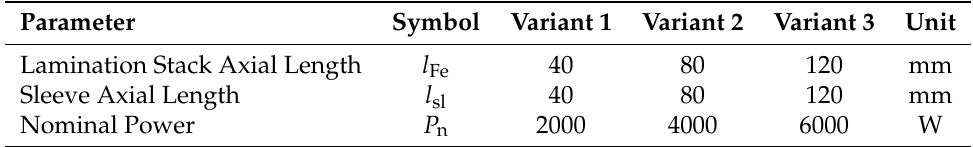
Table 1. Machine parameters for Variant